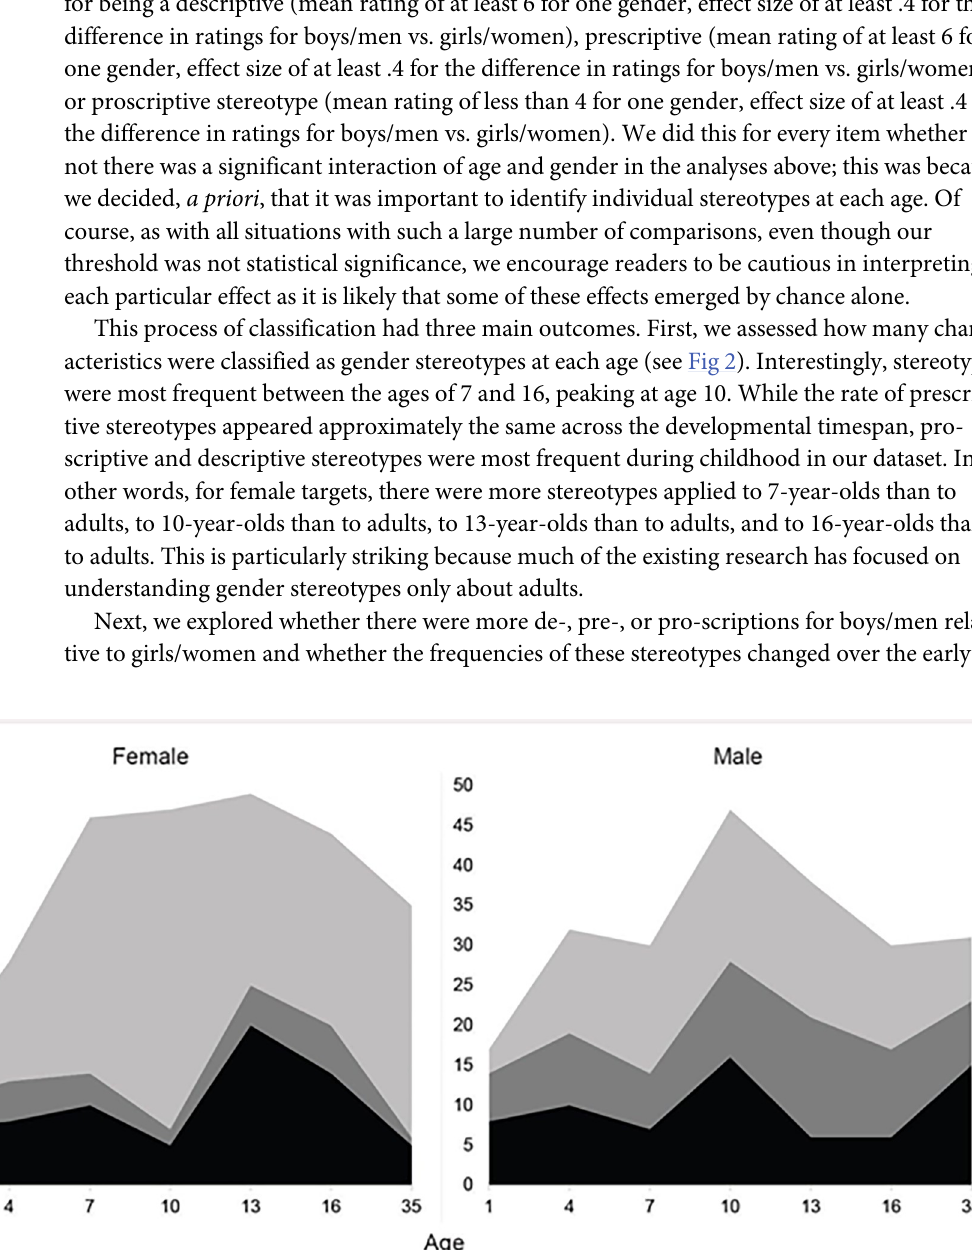
PLOS ONE | https://doi.org/10.1371/journal.pone.0263217 July 12,